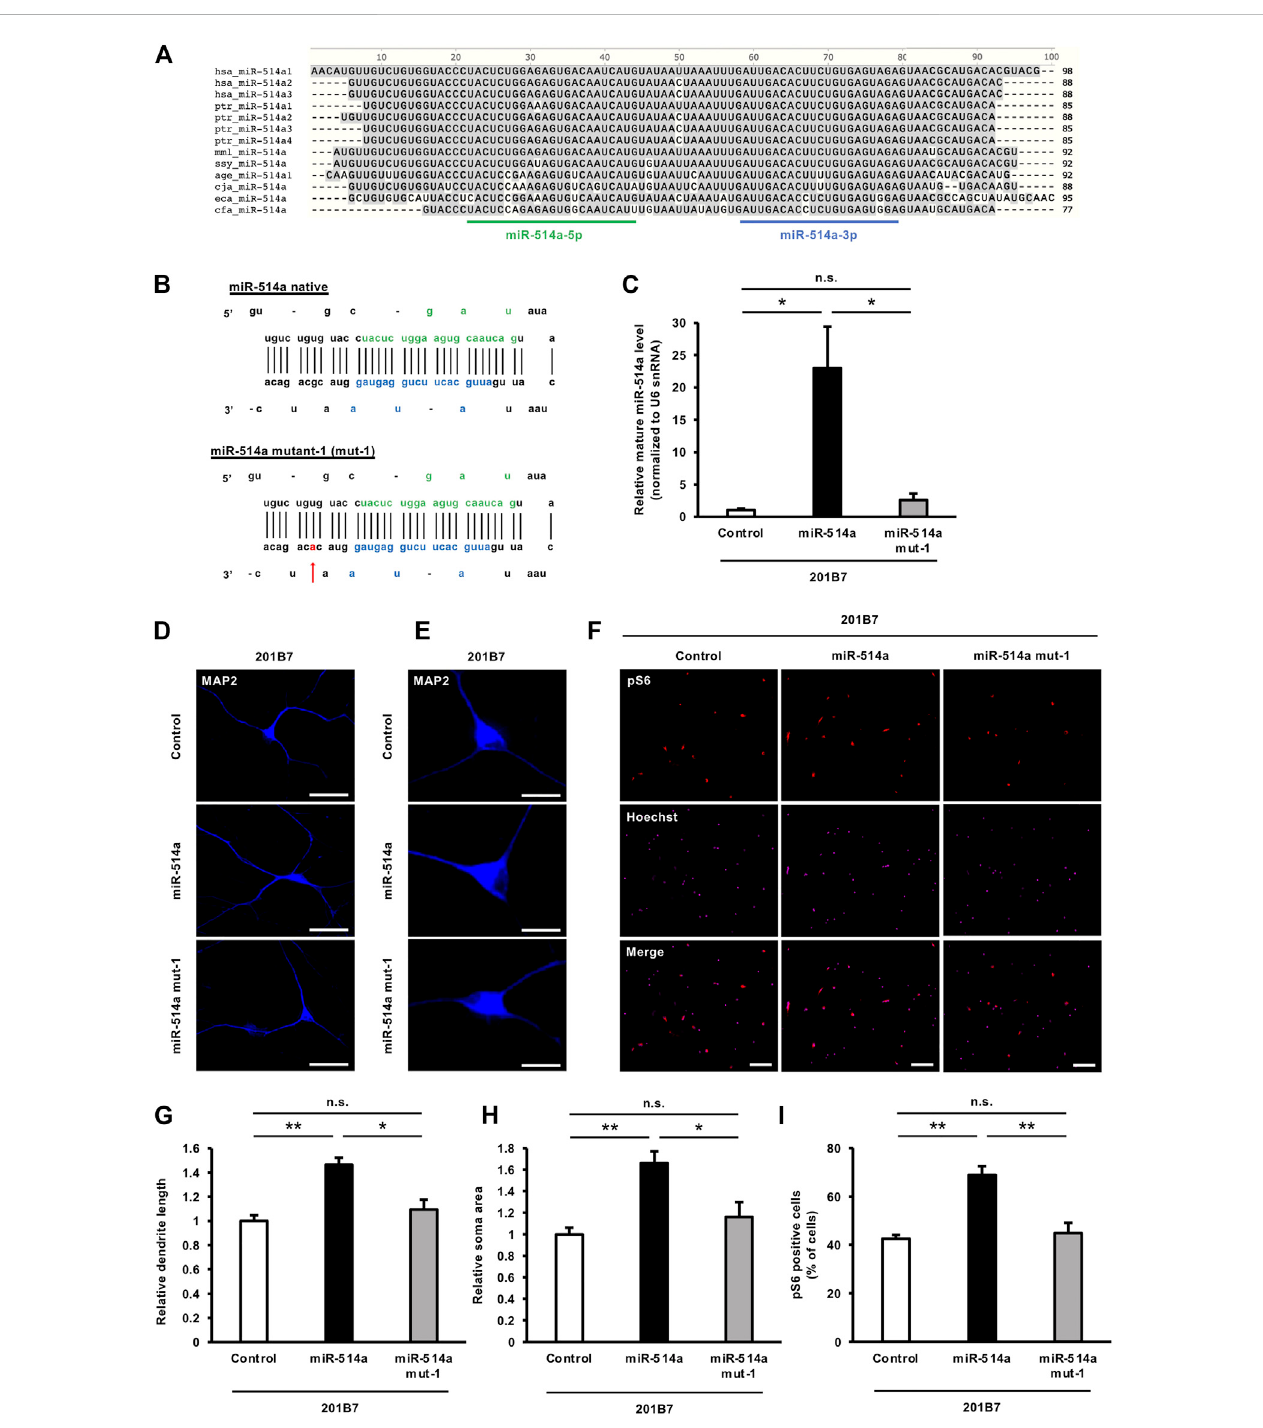
Variation in miR-514a sequences among primate genomes affects the expression level of mature miR-514a. (A) Comparison of sequence of precursor- miR-514a across species. (B) Schematic representation of the mutation in pre-miR-514a-3. (the nucleotide position in the mutation is indicated with arrow). (C) Expression levels of mature miR-514a were measured using qRT-PCR in 201B7 iPSC-derived neurons infected with lentiviruses expressing native miR- 514a,miR-514amutantorscrambledshRNAascontrol. n =3independentexperiments. (D) RepresentativeimagesofiPSC-derivedneuronsstainedwith anti-MAP2 (blue) antibody at 7 DIV. Scale bars, 50 µm. (E) Representative images of iPSC-derived neurons stained with anti-MAP2 (blue) antibody at 7 DIV. Scalebars,25 µm. (F) Representativeimages ofiPSC-derived neuronsstainedwith anti-pS6 (red) antibody andHoechst33,258 (magenta) at7DIV. Scalebars, 100 µm. (G) Quantitative analysis of total dendrite length. n = 3 independent experiments, at least 100 neurons were analyzed in each experiment. (H) Quantitativeanalysisofneuronalsomasize. n =3independentexperiments,atleast100neuronswereanalyzedineachexperiment. (I) Quantitativeanalysisof pS6 positive cells. n = 3 independent experiments, at least 200 cells were analyzed in each experiment. ** p < 0.01, * p < 0.05. Abbreviations: MAP2, microtubule-associated protein 2; pS6, phospho-S6 ribosomal protein; n. s., not signi fi